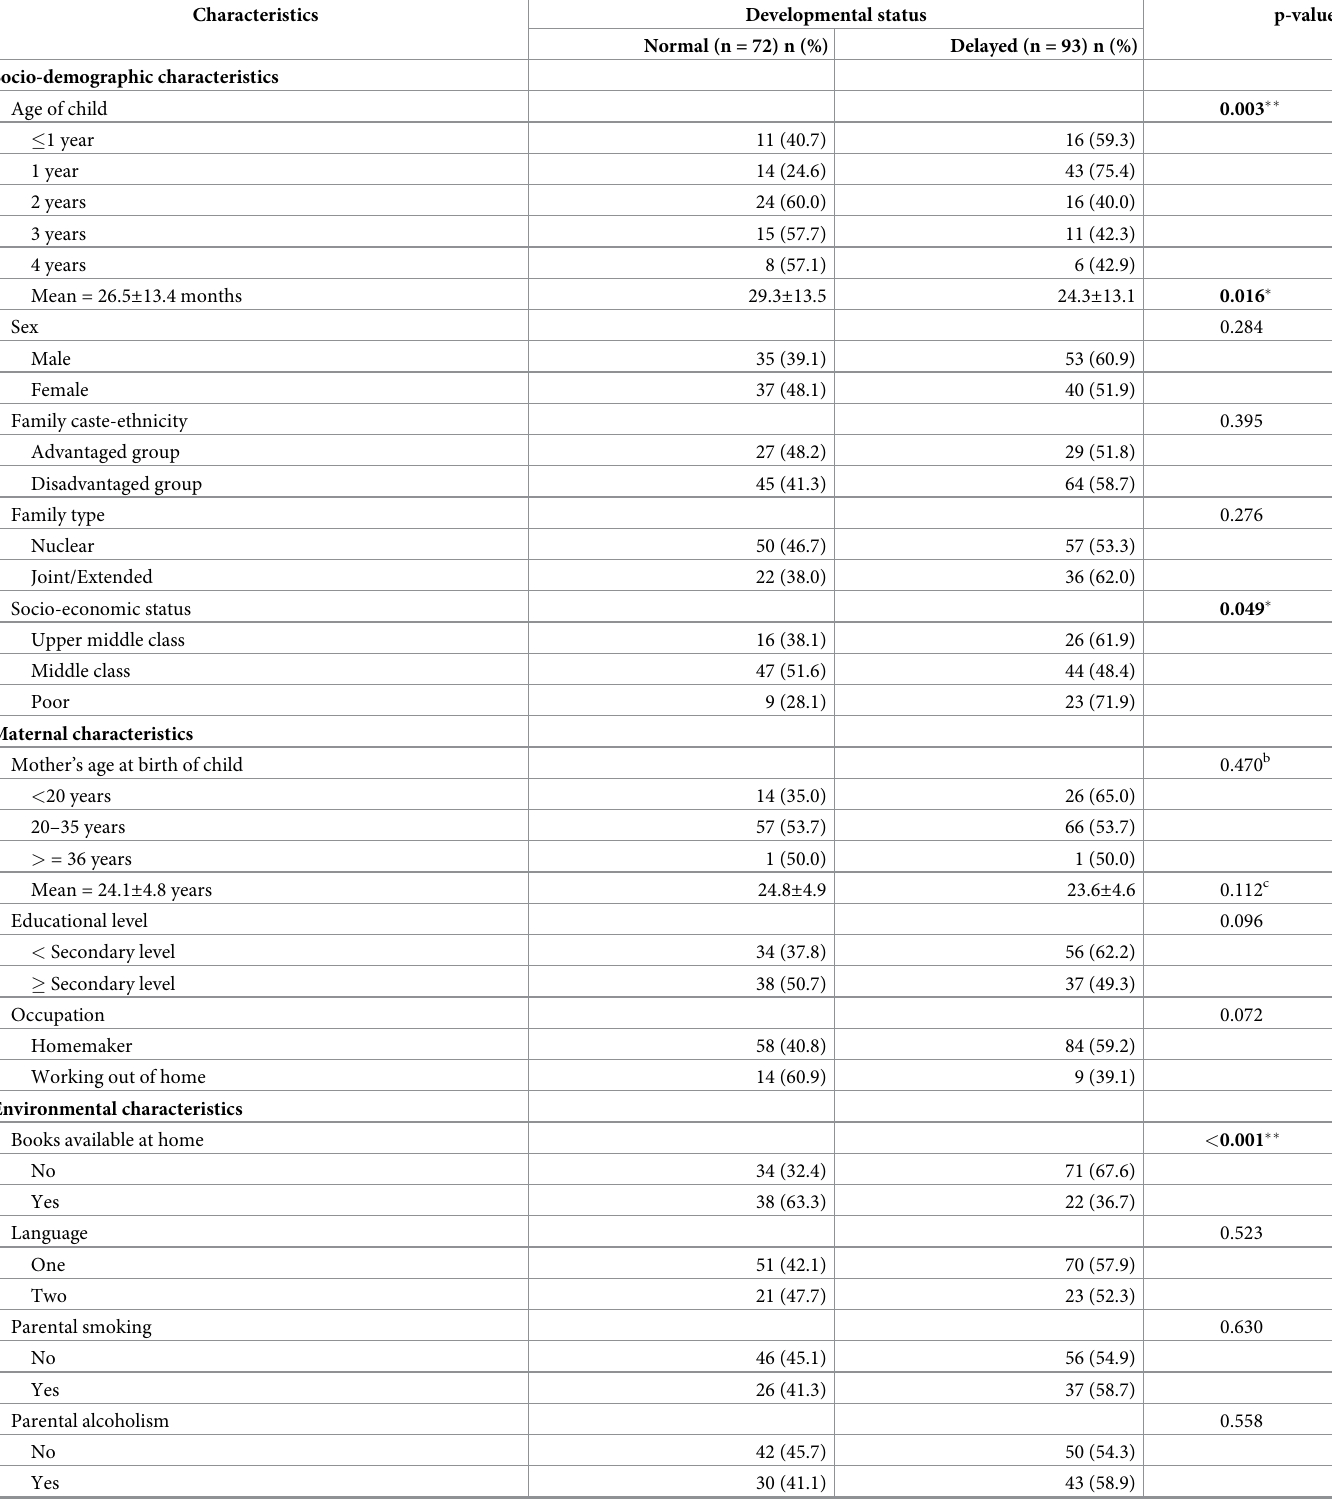
Table 5. Association of socio-demographic, environmental, biological and anthropometric characteristics, and developmental status of children (n =